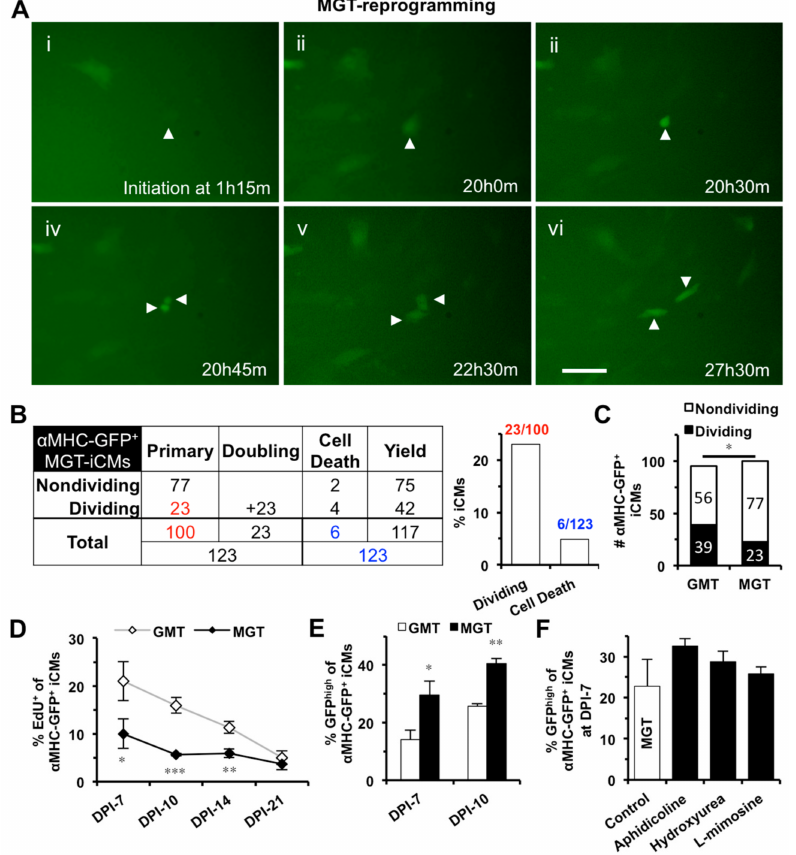
Figure 4. S-phase synchronization could not further improve the enhanced reprogramming of polycistronic construct (MGT). ( A ) Representative images of time-lapse recording showing that one MGT-iCM (arrowhead) divided into two daughter iCMs. Scale bar indicates 50 µ m. ( B ) A table summarizing the time-lapse result of all three batches of MGT-reprogrammed α MHC-GFP + iCMs. Numbers in red were used to calculate the percentage of dividing primary MGT-iCMs and numbers in blue for the percentage of cell death among total iCMs, which were summarized in the bar graph. ( C ) Time-lapse recordings revealed significantly less dividing cells among MGT-iCMs than GMT-iCMs. ( D ) EdU assays showed that MGT-iCMs exited cell cycle earlier than GMT-iCMs ( n = 4). ( E ) MGT-reprogramming yielded more GFP high iCMs than GMT-reprogramming at DPI-7 ( n = 7) and DPI-10 ( n = 3). ( F ) S-phase synchronization at DPI-1 had no significant improvement on MGT-reprogramming ( n = 4). * p < 0.05, ** p < 0.01, *** p < 0.001 vs.